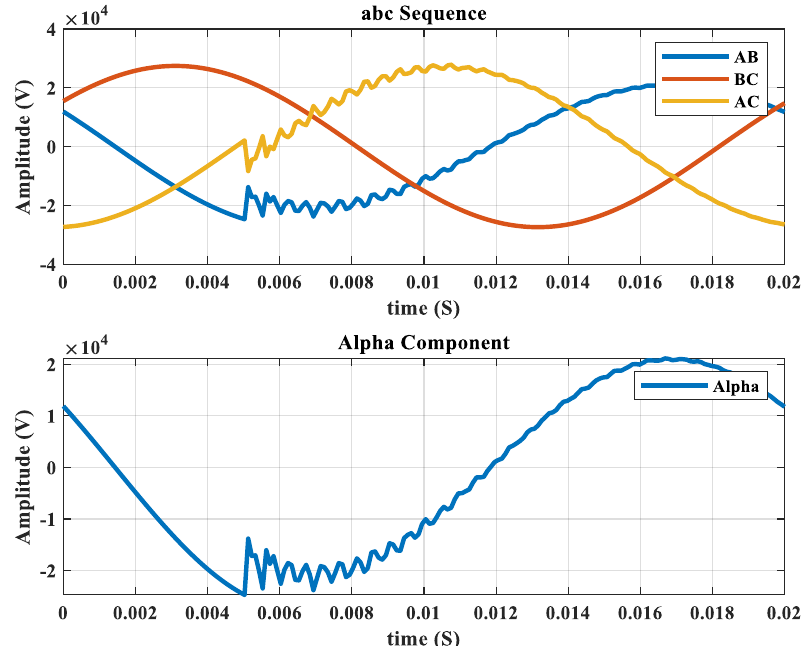
Figure 1. ABC sequence and alpha component of voltage waveform for a sample fault.